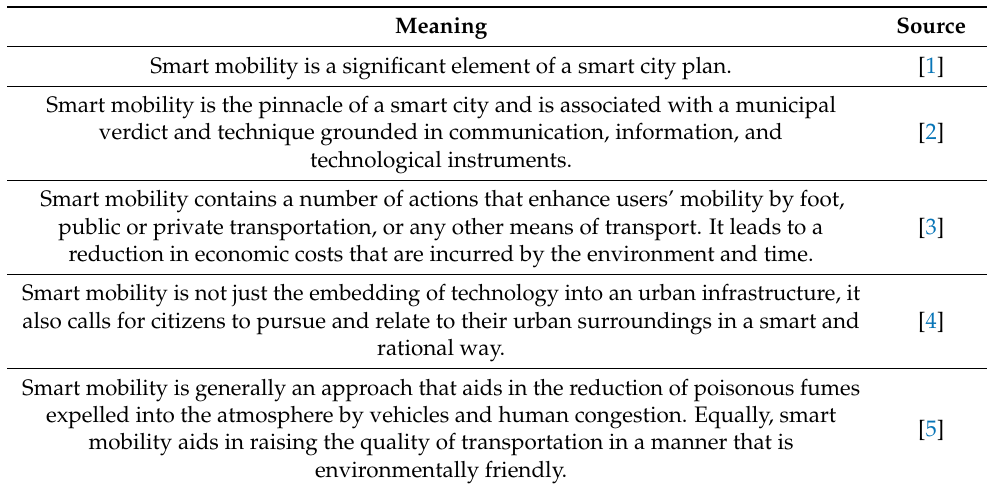
Table 1. Meanings of smart mobility. Meaning